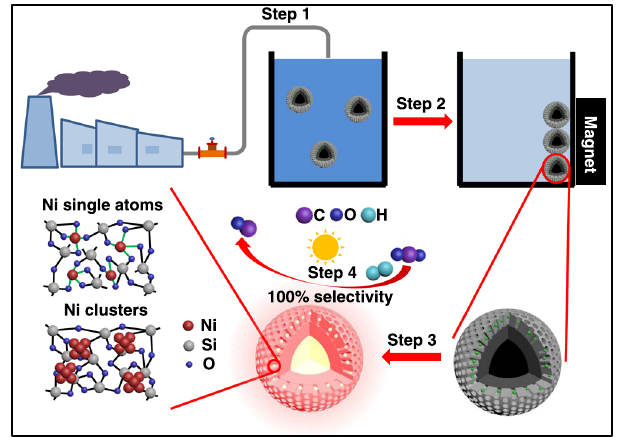
Fig. 1 | Schematic demonstrating the recycle of Ni from real electroplating wastewater. The Ni resources in the electroplating wastewater were upcycled for photothermal CO 2 catalysis